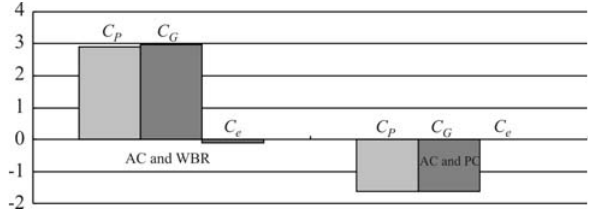
Figure 1 - The unconditional analysis covariance components between amylose content (AC) and weight of brown rice (WBR) or AC and protein content (PC). Figure shows phenotypic covariance ( C P ), genotypic cova- riance ( C G ) and residual covariance ( C e ).